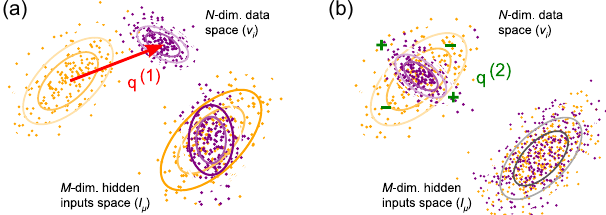
FIG. 4. First- and second-order constraints. (a) The first-order constraint (6) ensures that the classes have the same means in input space by imposing orthogonality of the weights to the vector separating their centers of mass in data space (red). (b) Second-order constraints (9) ensure that the two classes have the same covariance in input